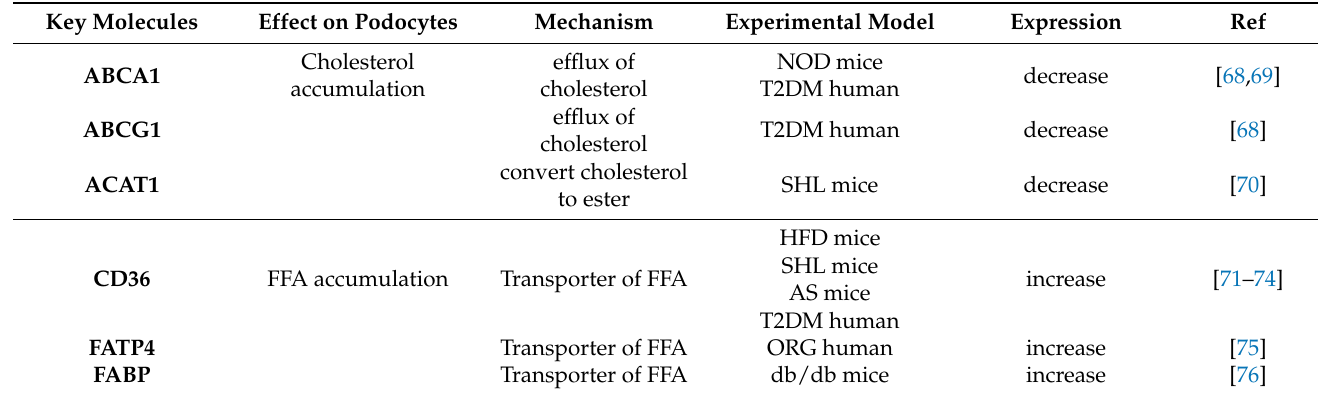
Table 2. Key molecules associated with lipotoxicity in